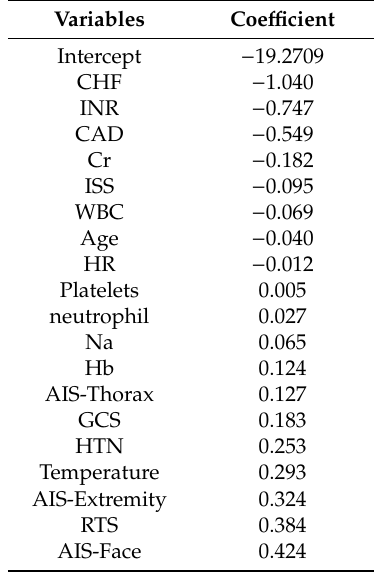
Table A1. The independent risk predictors factors and the coe ffi cient in LR model.